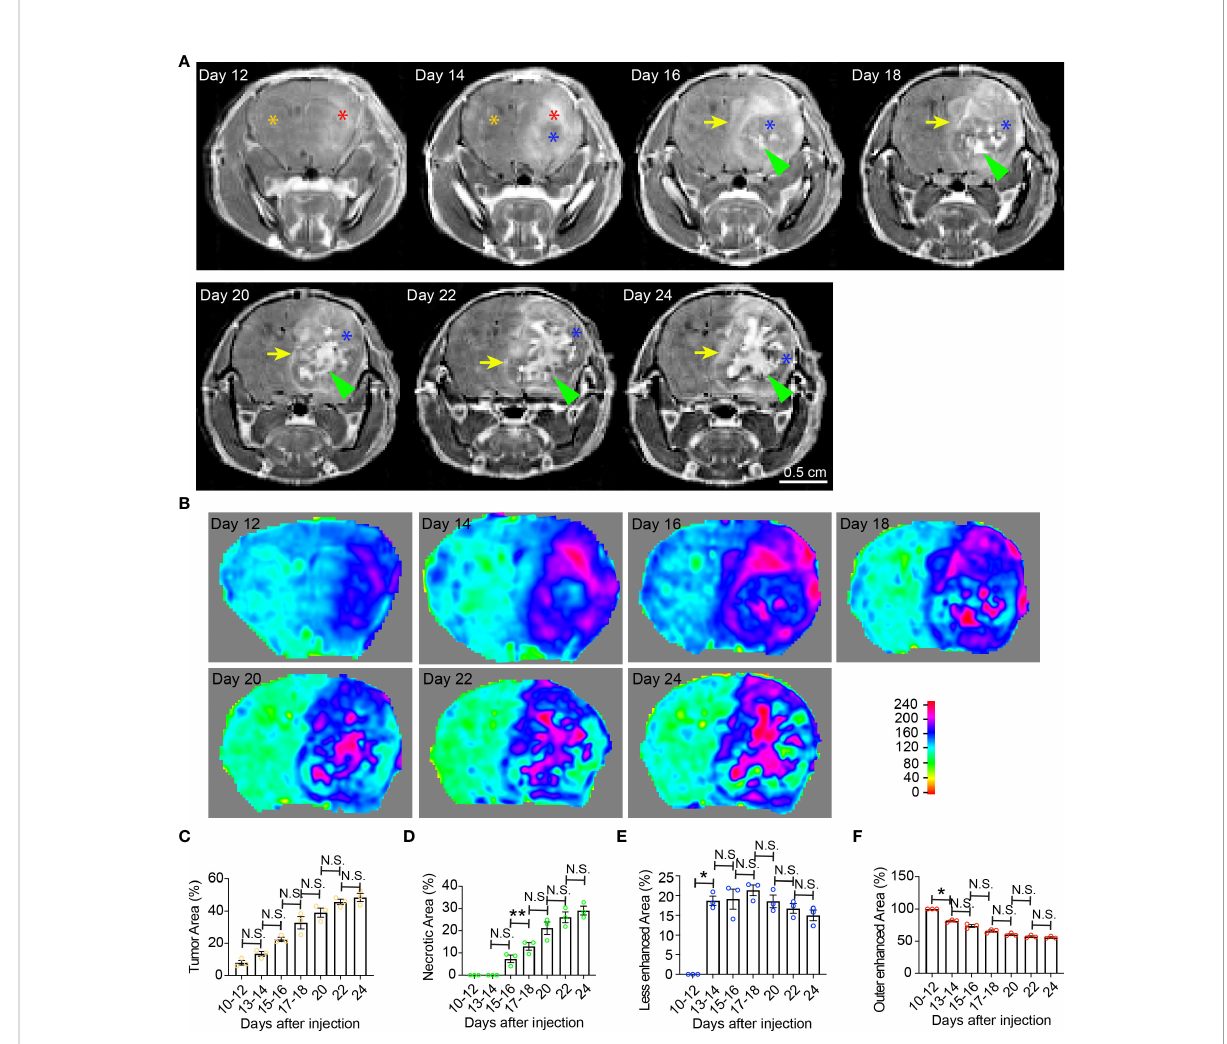
FIGURE 1 Temporal radiographic characterization of tumor necrosis development during early tumor progression via MR imaging. (A) Temporal development of GBM tumor necrosis during early, asymptomatic stages of tumor progression via representative serial T1-weighted post-gadolinium MRI scans of one LN229TAZ(4SA) tumor-bearing mouse. Orange asterisk: Normal brain parenchyma in the non-tumor containing hemisphere; red asterisk: Enhancing areas in the tumor-containing hemisphere; blue asterisk: The center of the tumor becomes less enhancing from day 14 onward, likely representing densely packed tumor cells; green arrowheads: Prominently enhancing foci within the less enhancing tumor stroma, likely representing active development of necrosis, which starts appearing from day 16. Yellow arrows: Peripheral enhancing interface between the less enhancing tumor tissue, as marked by blue asterisks, and the normal brain parenchyma. (B) Heatmaps of signal intensities generated using T1 post-contrast MRI images as in panel (A) . (C) Quanti fi cation of tumor area (outlined by the peripheral enhancing interface indicated by yellow arrows) normalized to whole brain area at each timepoint indicated above in panel (A) . p ANOVA =0.003. Results of post hoc test for each continuous time point are indicated. (D) Quanti fi cation of necrotic areas — labeled by green arrowheads in panel (A) — normalized to corresponding tumor at each timepoint indicated above. p ANOVA =0.0009. Results of post hoc test for each continuous time point were indicated. (E) Quanti fi cation of less-enhancing areas — labeled by blue asterisks in panel (A) — normalized to corresponding tumor at each timepoint indicated above. p ANOVA =0.012. Results of post hoc test for each continuous time point are indicated. (F) Quanti fi cation of the outer enhanced areas — labeled by red asterisks in panel (A) — normalized to corresponding tumor at each timepoint indicated above. p ANOVA =0.0011. Results of post hoc test for each continuous time point are indicated. Three mice were imaged as replicates with consistent observations; each datapoint shown in the bar graphs represents an animal (n=3). RM one-way ANOVA. Sidak ’ s multiple comparisons test was used in the post hoc test. All center values shown are mean values, and all error bars represent standard errors of the means (s.e.m). N.S.,p > 0.05. *,p < 0.05; **,p